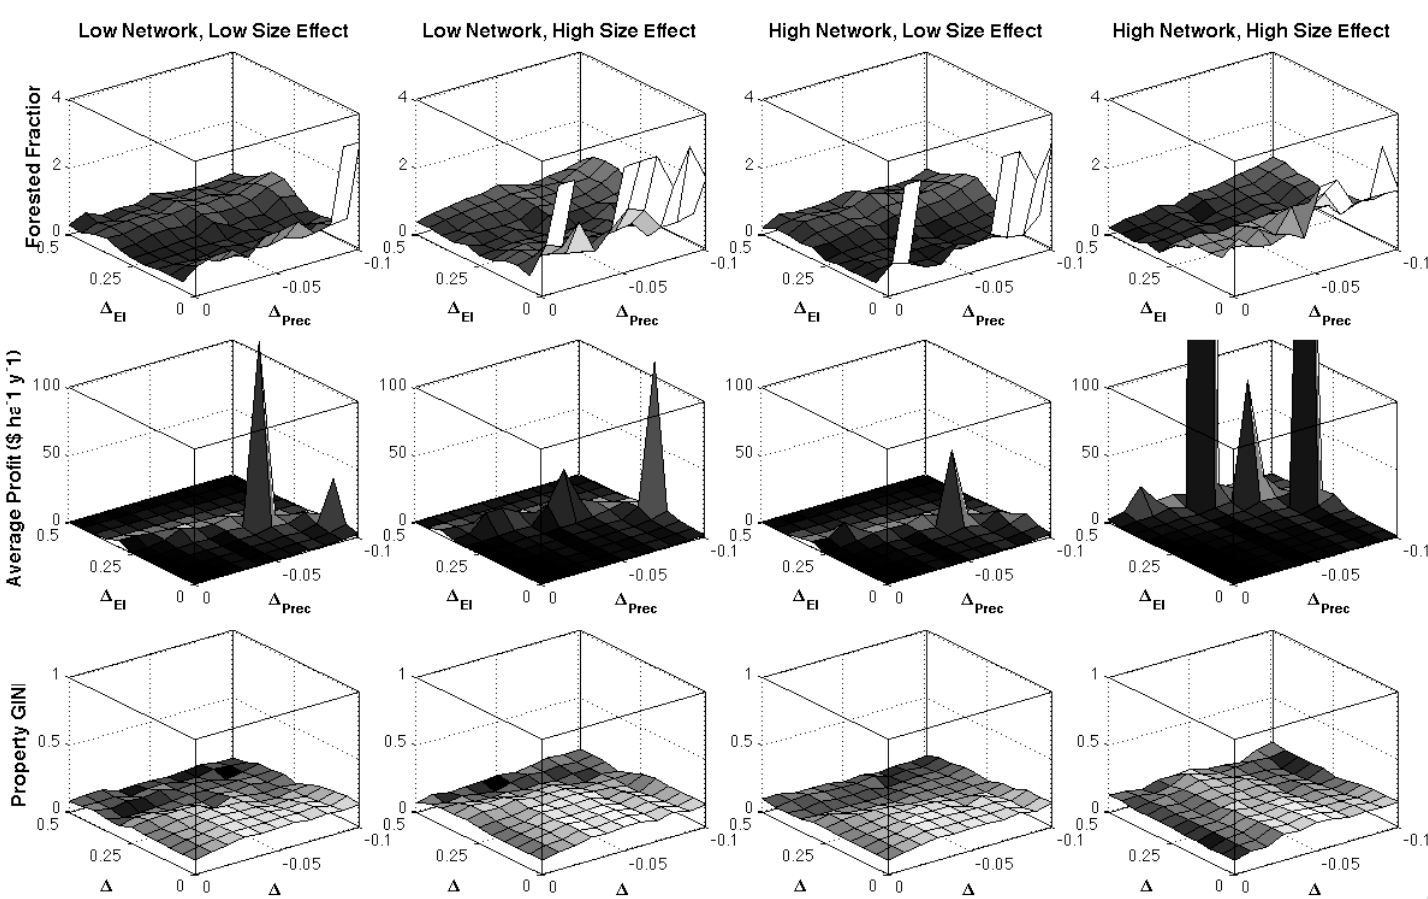
Figure A5.5: Standard deviations for response surfaces for Policy Scenario 1 – Sensitivity to change in expected income Δ EI and in precipitation Δ Prec , non­tiered environmental licensing. Surfaces in row 1 show standard deviation for forested fraction across the landscape; row 2 shows standard deviation for profit per hectare of property per year; row 3 shows the standard deviation for level of land aggregation measured by the property GINI coefficient. Each column represents a different scenario of rancher interaction. Values reflect the standard deviation across n replicates, divided by the mean across the n